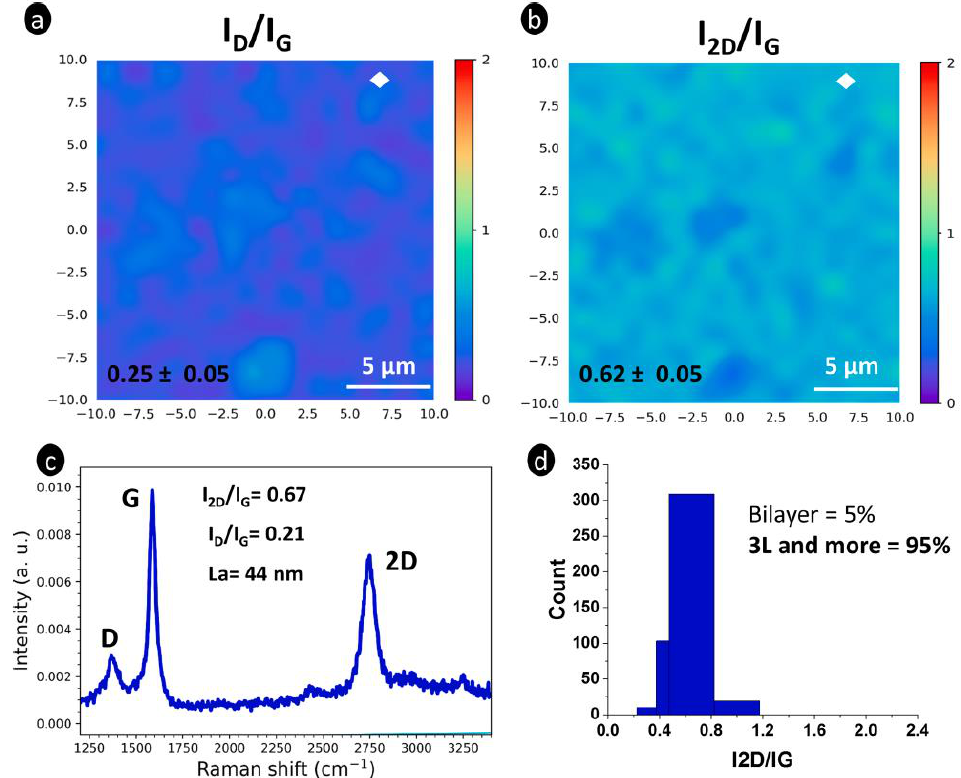
Figure 8. Raman analysis of the synthesized few-layer graphene; ( a ) a Raman map of the ratio of intensity of the D-band to the G-band; ( b ) a Raman map of ratio of the intensity of the 2D band to the G-band; ( c ) Raman spectra of few-layer graphene; ( d ) the distribution of the number of graphene layers in few-layer graphene. Reproduced from [82] with the permission of Elsevier.